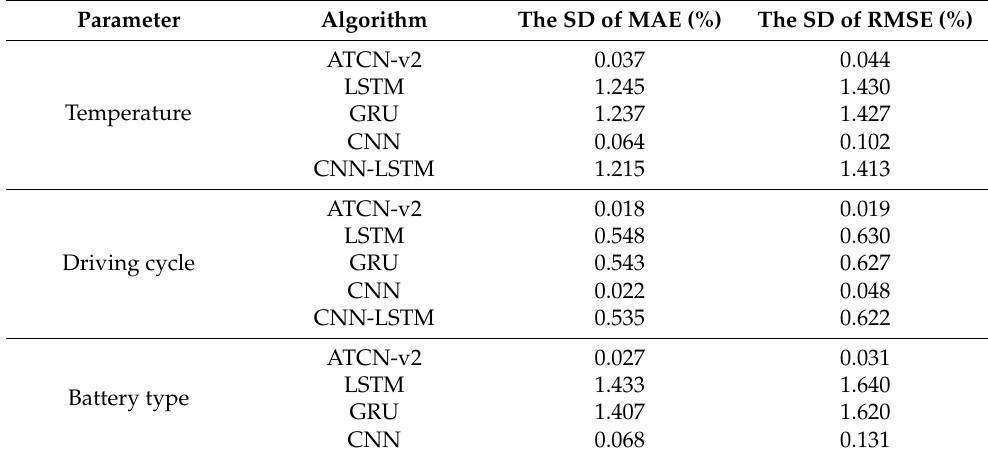
Table 5. SOC estimation performance of the ATCN-v2 model for different types of batteries under different real driving cycles and temperatures. Parameter Algorithm The SD of MAE (%) The SD of RMSE (%)